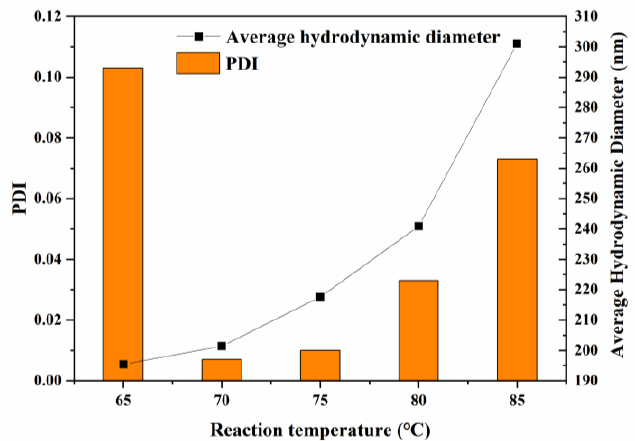
Figure 5. DLS characterization of PSt microspheres synthesized with different reaction temperatures.